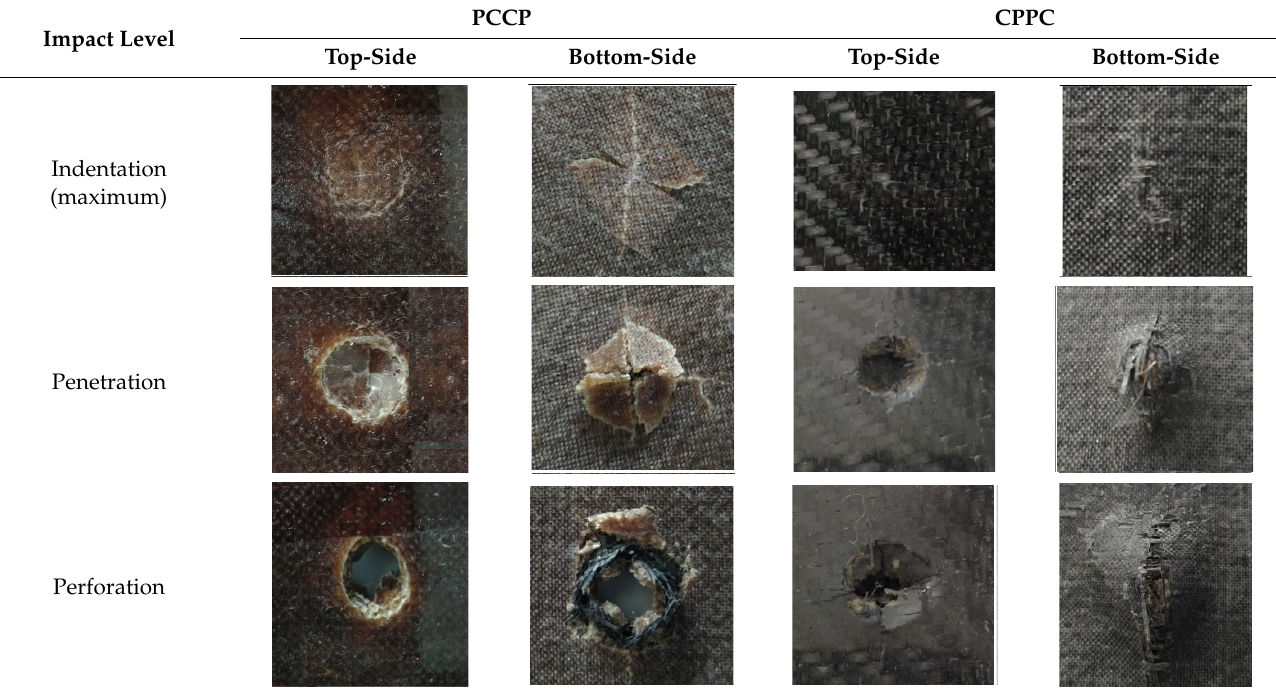
Table 5. Damaged areas of the PCCP and CPPC at a ply orientation of [0 ◦ /90 ◦ ] 8 .